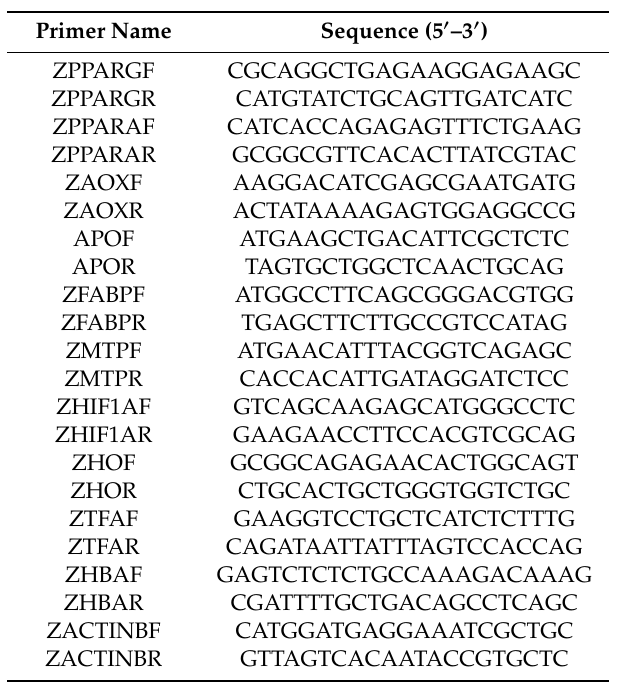
Table 1. Primers used in all